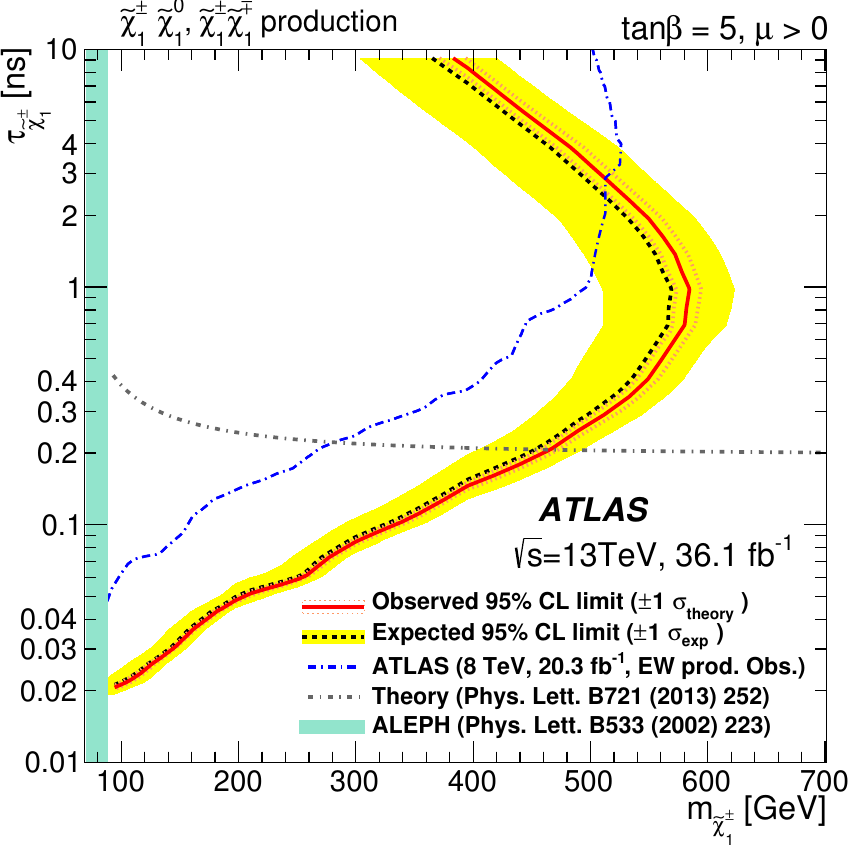
Figure 8 . Exclusion limit at 95% CL obtained in the electroweak production channel in terms of the chargino lifetime ( (cid:28) ) and mass ( m ). The yellow band shows the 1 (cid:27) region of the ~ (cid:31) (cid:6) 1 ~ (cid:31) (cid:6) 1 distribution of the expected limits. The median of the expected limits is shown by a dashed line. The red line shows the observed limit and the orange dotted lines around it show the impact on the observed limit of the variation of the nominal signal cross-section by (cid:6) 1 (cid:27) of its theoretical uncertainties. Results are compared with the observed limits obtained by the previous ATLAS search with disappearing tracks and tracklets [19] and an example of the limit obtained at LEP2 by the ALEPH experiment [61]. The chargino lifetime as a function of the chargino mass is shown in the almost pure wino LSP scenario at the two-loop level